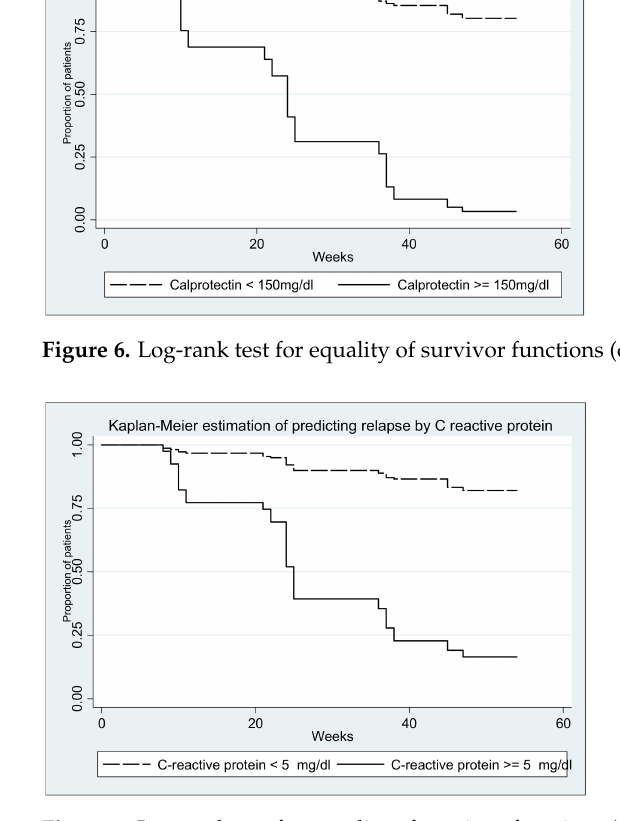
Figure 7. Log-rank test for equality of survivor functions (C reactive protein) p < 0.00001.